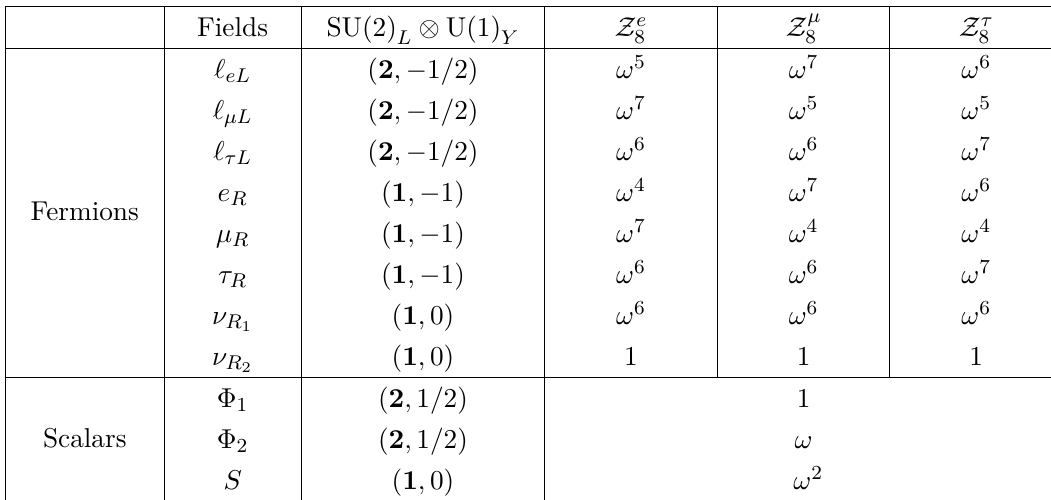
symmetry we have ω k = e ikπ/ 4 . 8